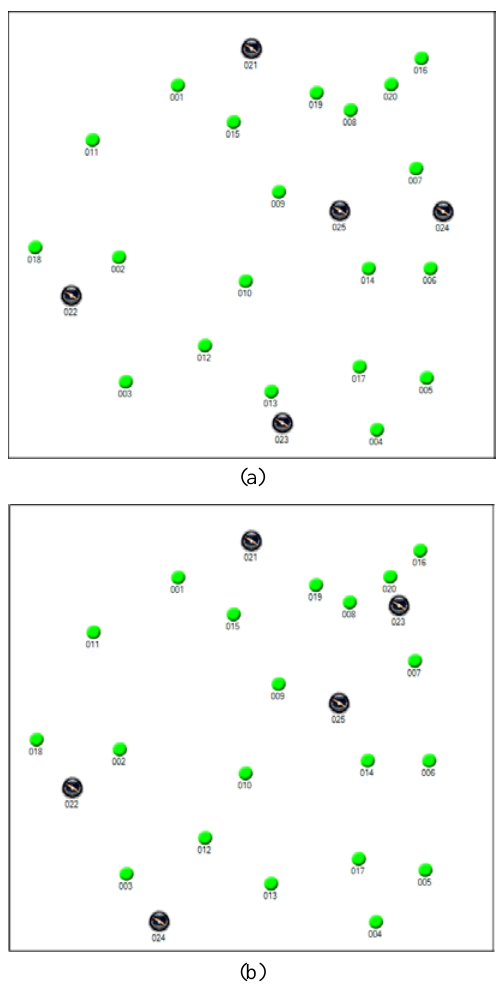
Fig.6. Topology of beacon nodes and unknown nodes: (a) before the state changing; (b) afer the state changing.